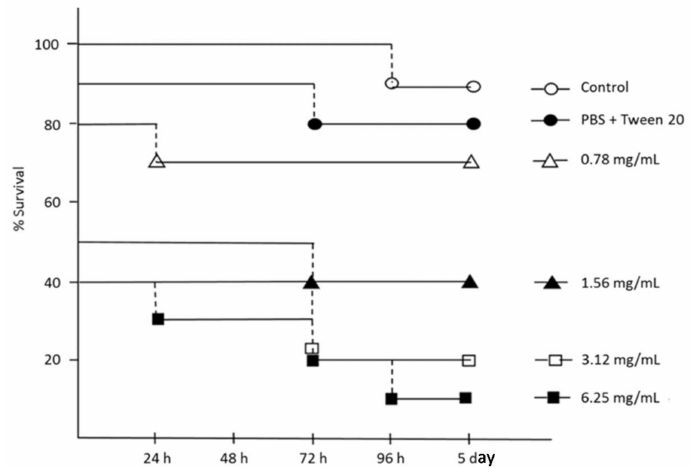
Figure 5. Survival curves of Galleria mellonella larvae after hemp EO treatment. Each data point represents the percent survival of G. mellonella larvae ( N = 10/group, repeated on three different occasions), following injection with test samples and incubation at 37 ◦ C. Control larvae were not injected or injected with phosphate-buffered saline (PBS) plus Tween 20 to simulate the trauma associated with the administration. Larvae were monitored for 24 h up to five